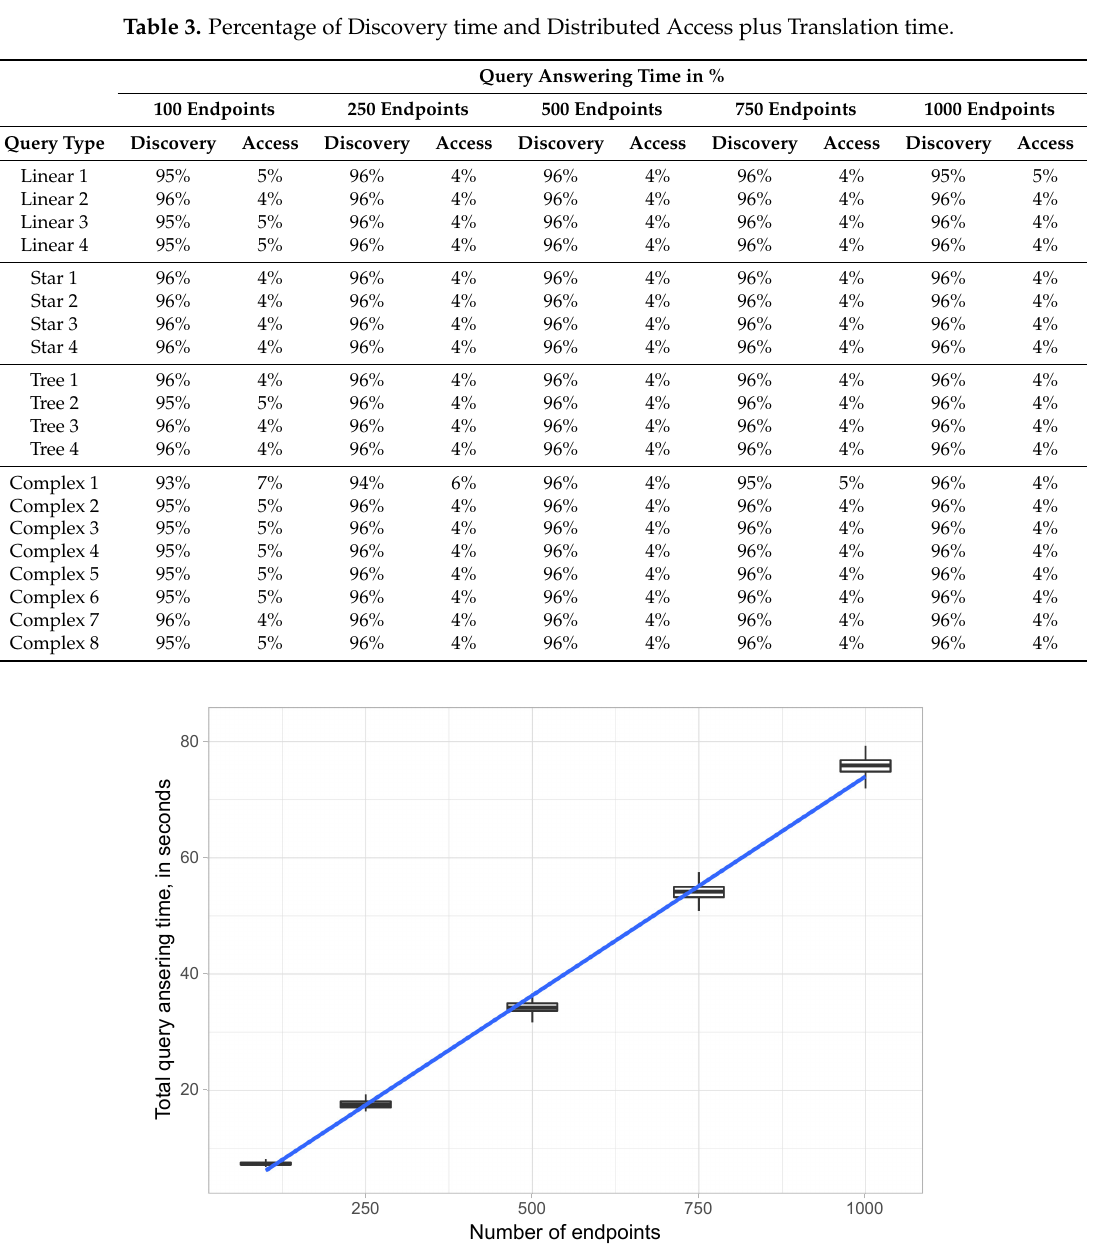
Figure 5. Averaged results: whiskers and plot of the results obtained handling different numbers of